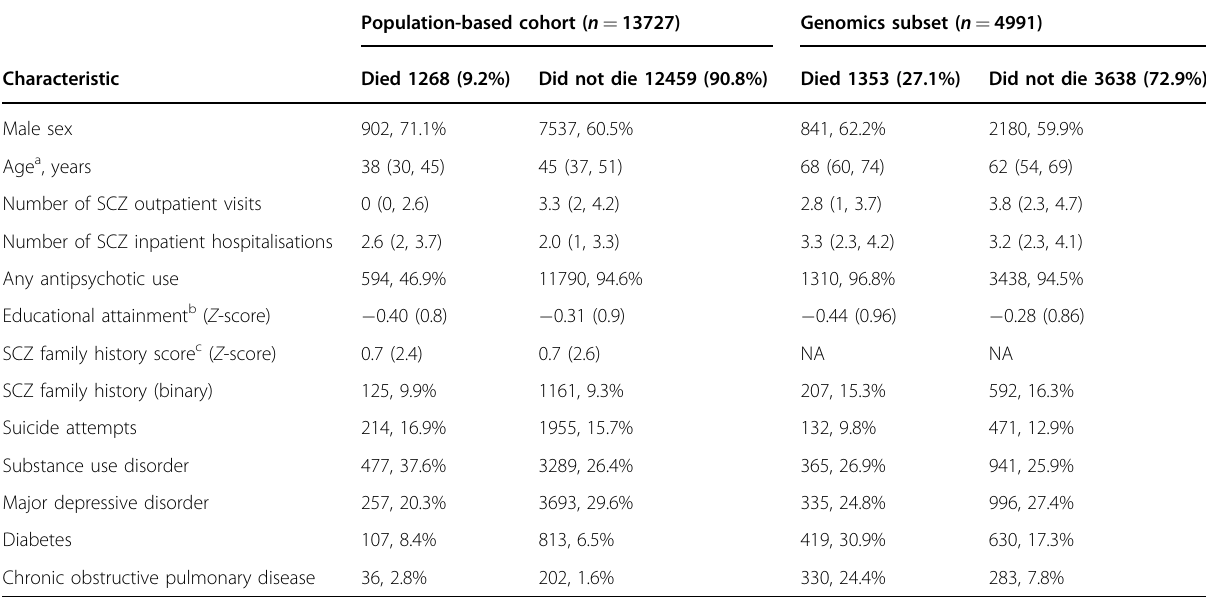
Table 1 Descriptive characteristics of schizophrenia cases who did or did not die during the study period from the population-based cohort and genomic